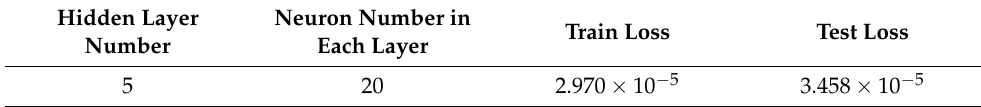
Table 11. Train and test loss of neural